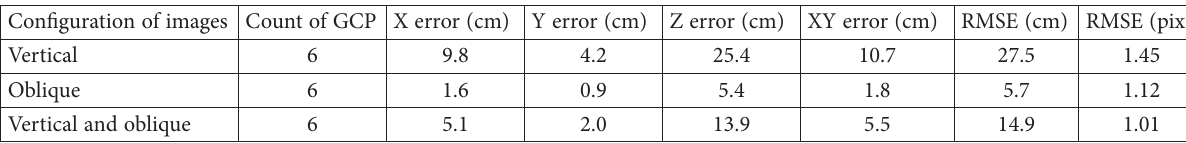
Table 2. Detailed distribution of model fitting errors on ground control points for the analyzed image variants, assuming the